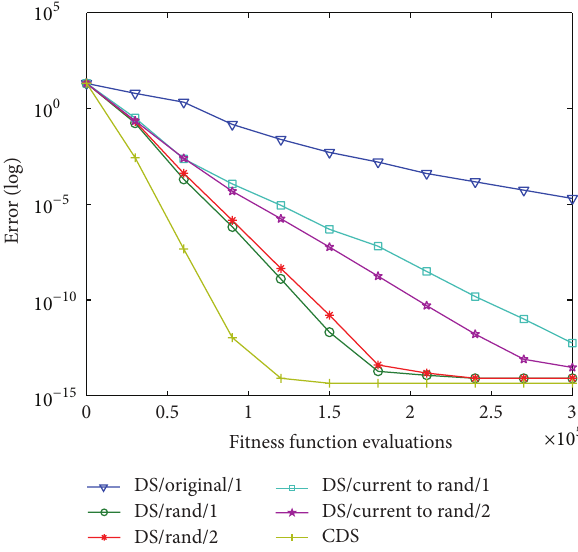
Figure 7: Comparison of performance of six algorithms for mini- mization of 𝑓 08 with dimension 30.